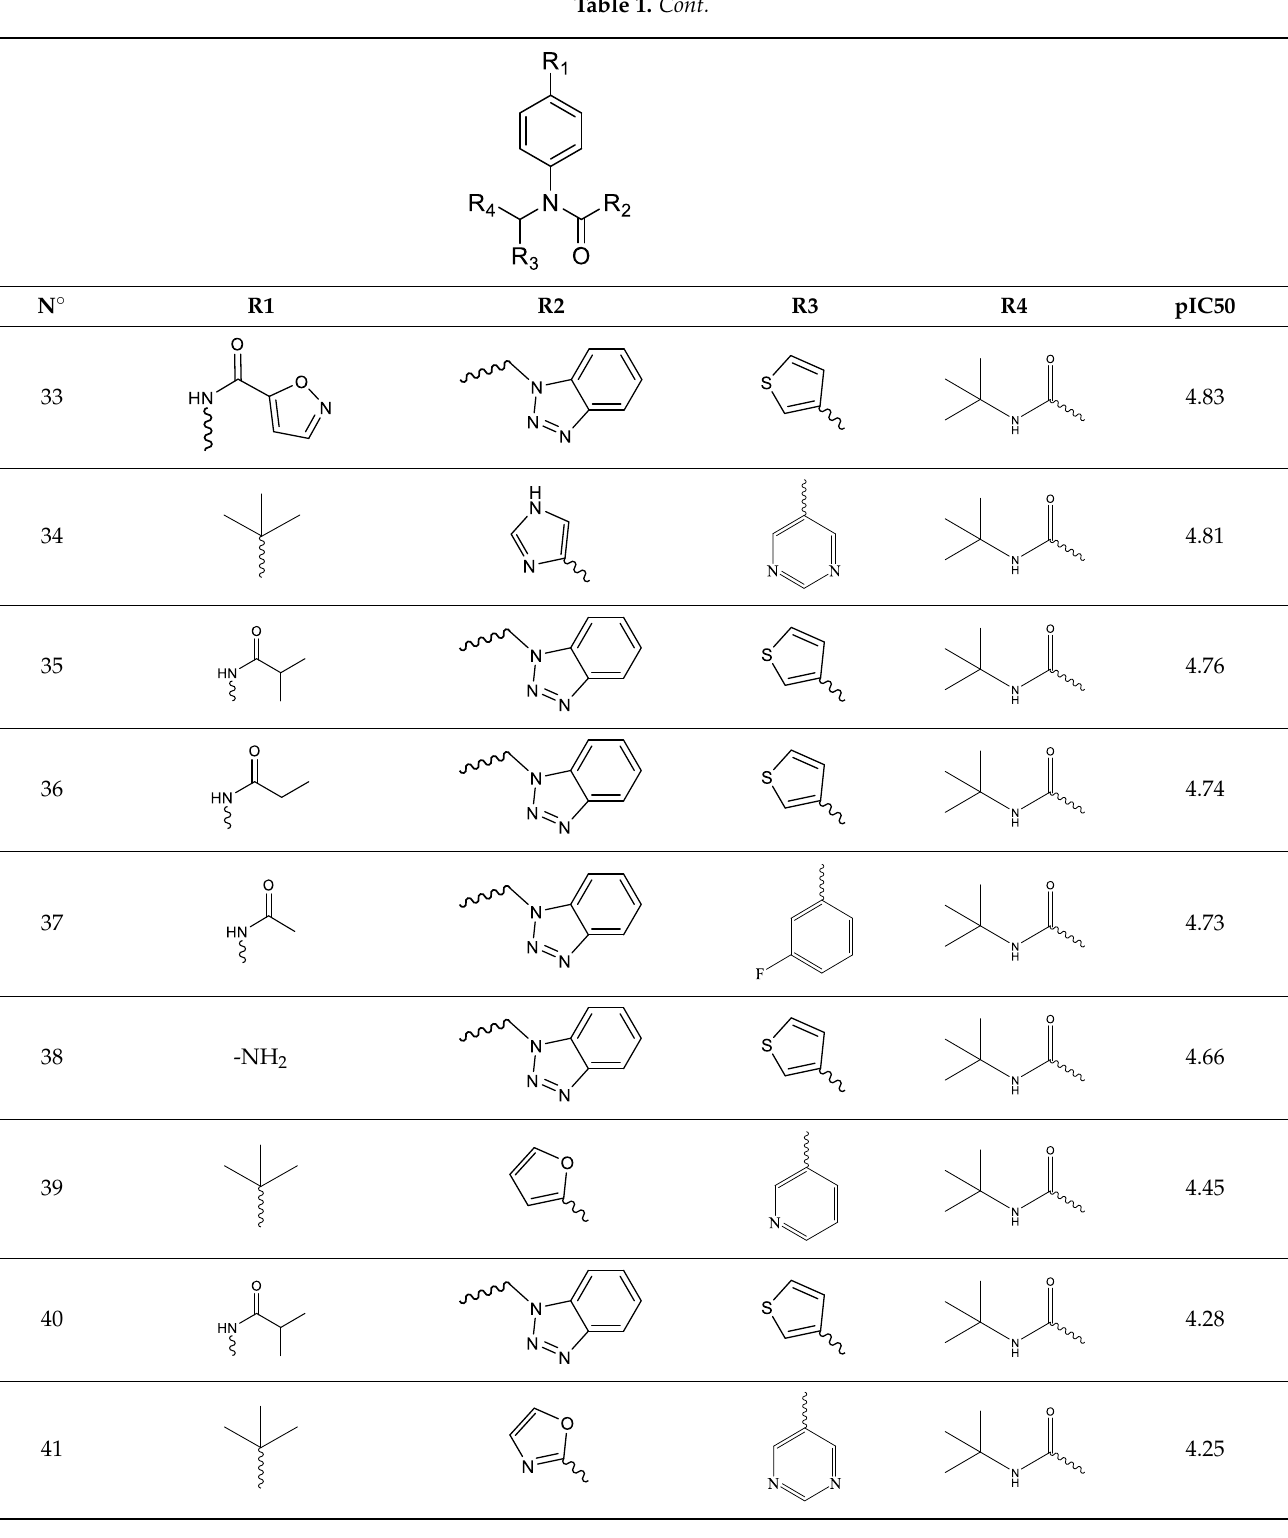
Table 1. Chemical structures and activity experiment of 41 peptidomimetic